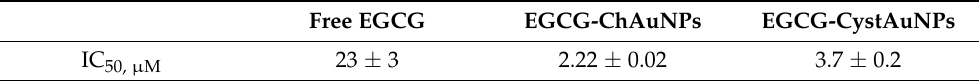
Table 3. Half maximal inhibitory concentration (IC 50 ) values on BxPC3 cells.